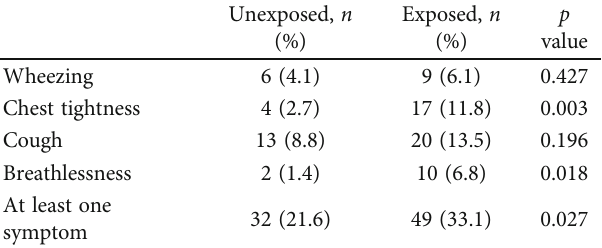
Table 3: Respiratory symptoms reported by e-waste workers in the informal sector (exposed, n = 148 ) compared to matched unexposed subjects ( n = 148 ) in Cotonou, Benin ( N = 296 ).